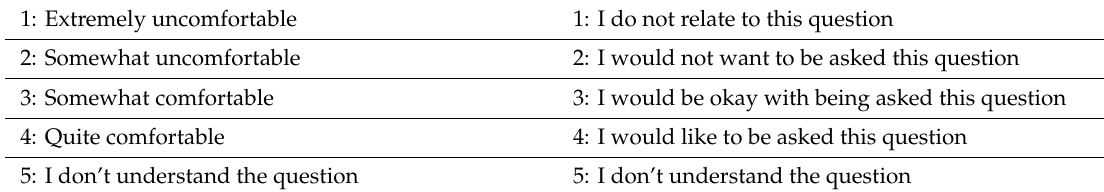
Table 1. Nurses’ and patients’ introductions and response options for all 21 questions in the Nurse Spiritual Assessment Questionnaire